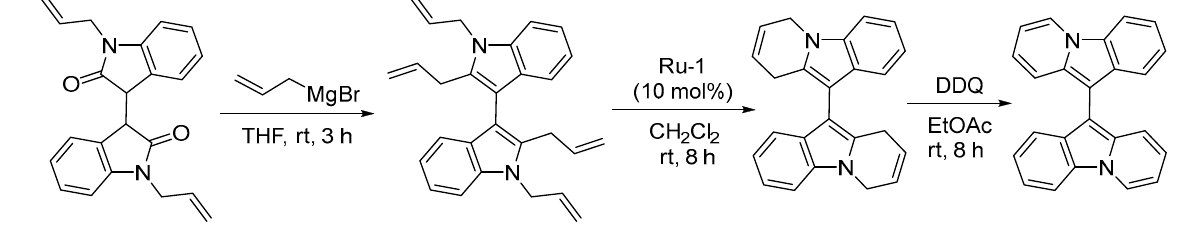
Scheme 28. Synthesis of dimeric pyridoindoles.